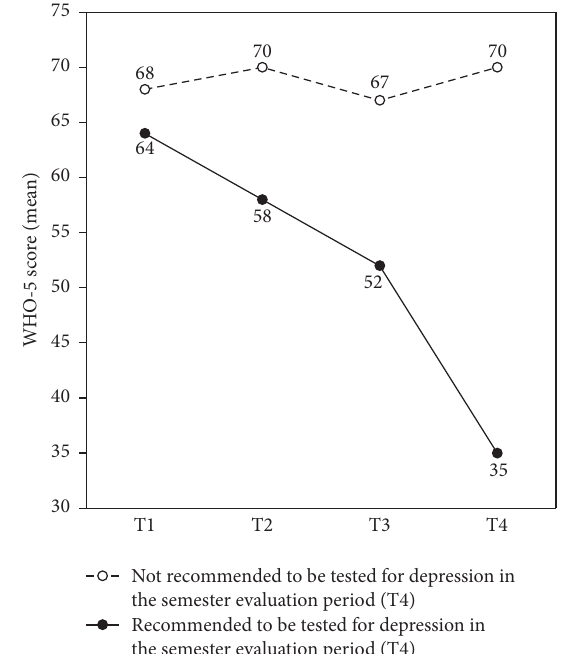
Figure 3: Subgroup analysis of the change of dental students’ positive well-being, according to their recommendation to be tested for depression in the semester evaluation period